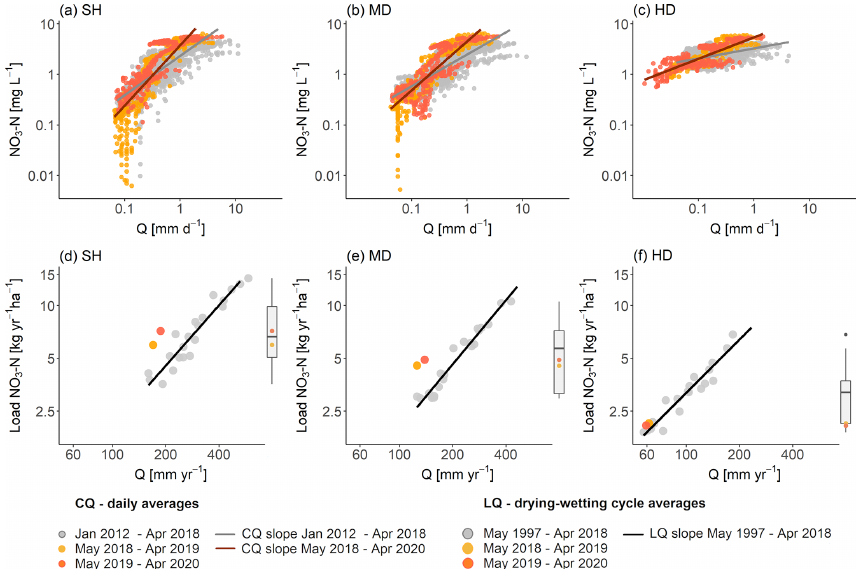
Figure 3. Concentration–discharge ( C – Q ) and load–discharge ( L – Q ) relationships for the three sub-catchments of the Selke catchment (SH, MD, and HD). (a–c) Daily averaged nitrate concentration and discharge data with log-transformed axes. The lines show the C – Q slope for daily averages before the 2-year drought (grey) and since the start of the 2-year drought (dark red). (d–f) Annual averages for loads and discharge in the log–log space since 1997 (years starting in May). Black lines show the L – Q slope previous to the 2-year drought. Box plots at the right side of each panel (d–f) show the distribution of data points within the pre-drought load range and drought cycles indicated as colored dots.